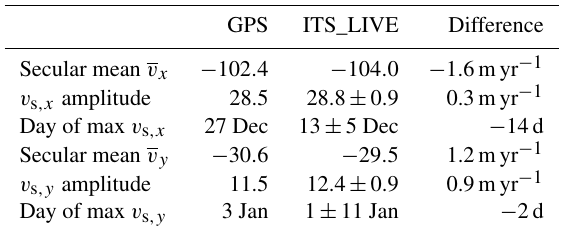
Table 2. ITS_LIVE analysis compared to GPS. The secular mean velocities and x and y components of the seasonal characteristics of the glacier velocity time series shown in Fig. 7. The acquisi- tion dates of the two independent measurements differ slightly, yet agreement is within a few percent by every measure. Uncertainty estimates are described in Appendix